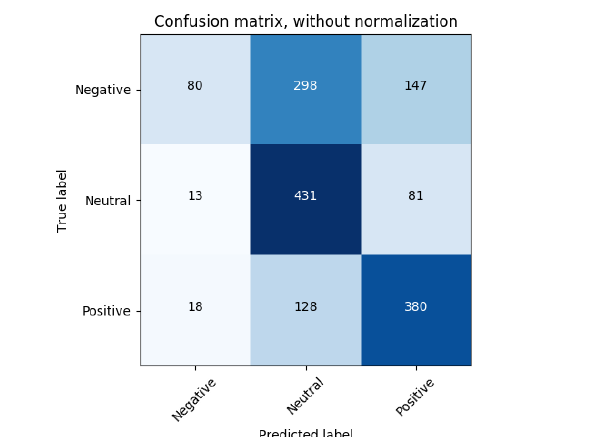
Figure 5. Confusion matrix for ResNetInceptionV2 network.